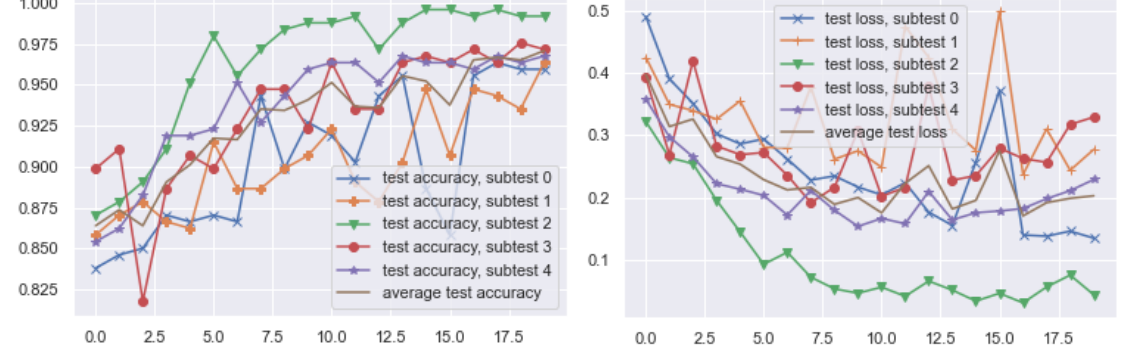
Figure 9. Class 0 vs. Class III. Model: the LeNet model from Figure 5 was applied. Validation technique: cross-validation 5. Accuracy for 20 iterations of neural network training and corresponding cross-entropy loss. Validation takes place after every epoch of